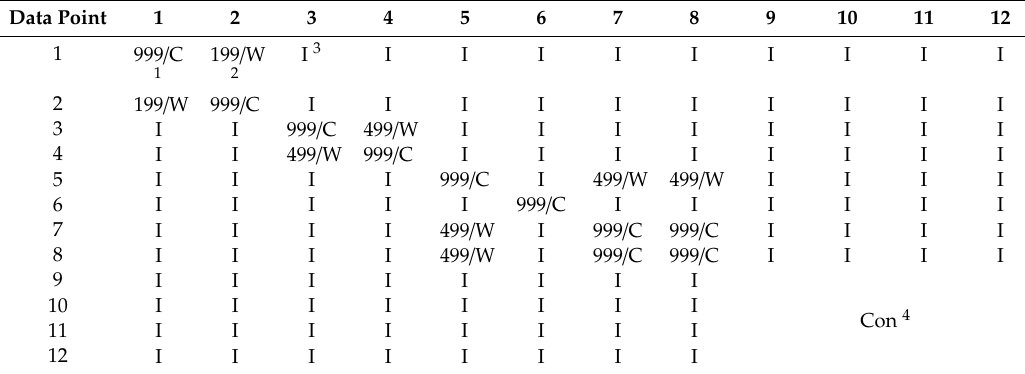
Table 7. Consistency degree and relationships of the data in Table